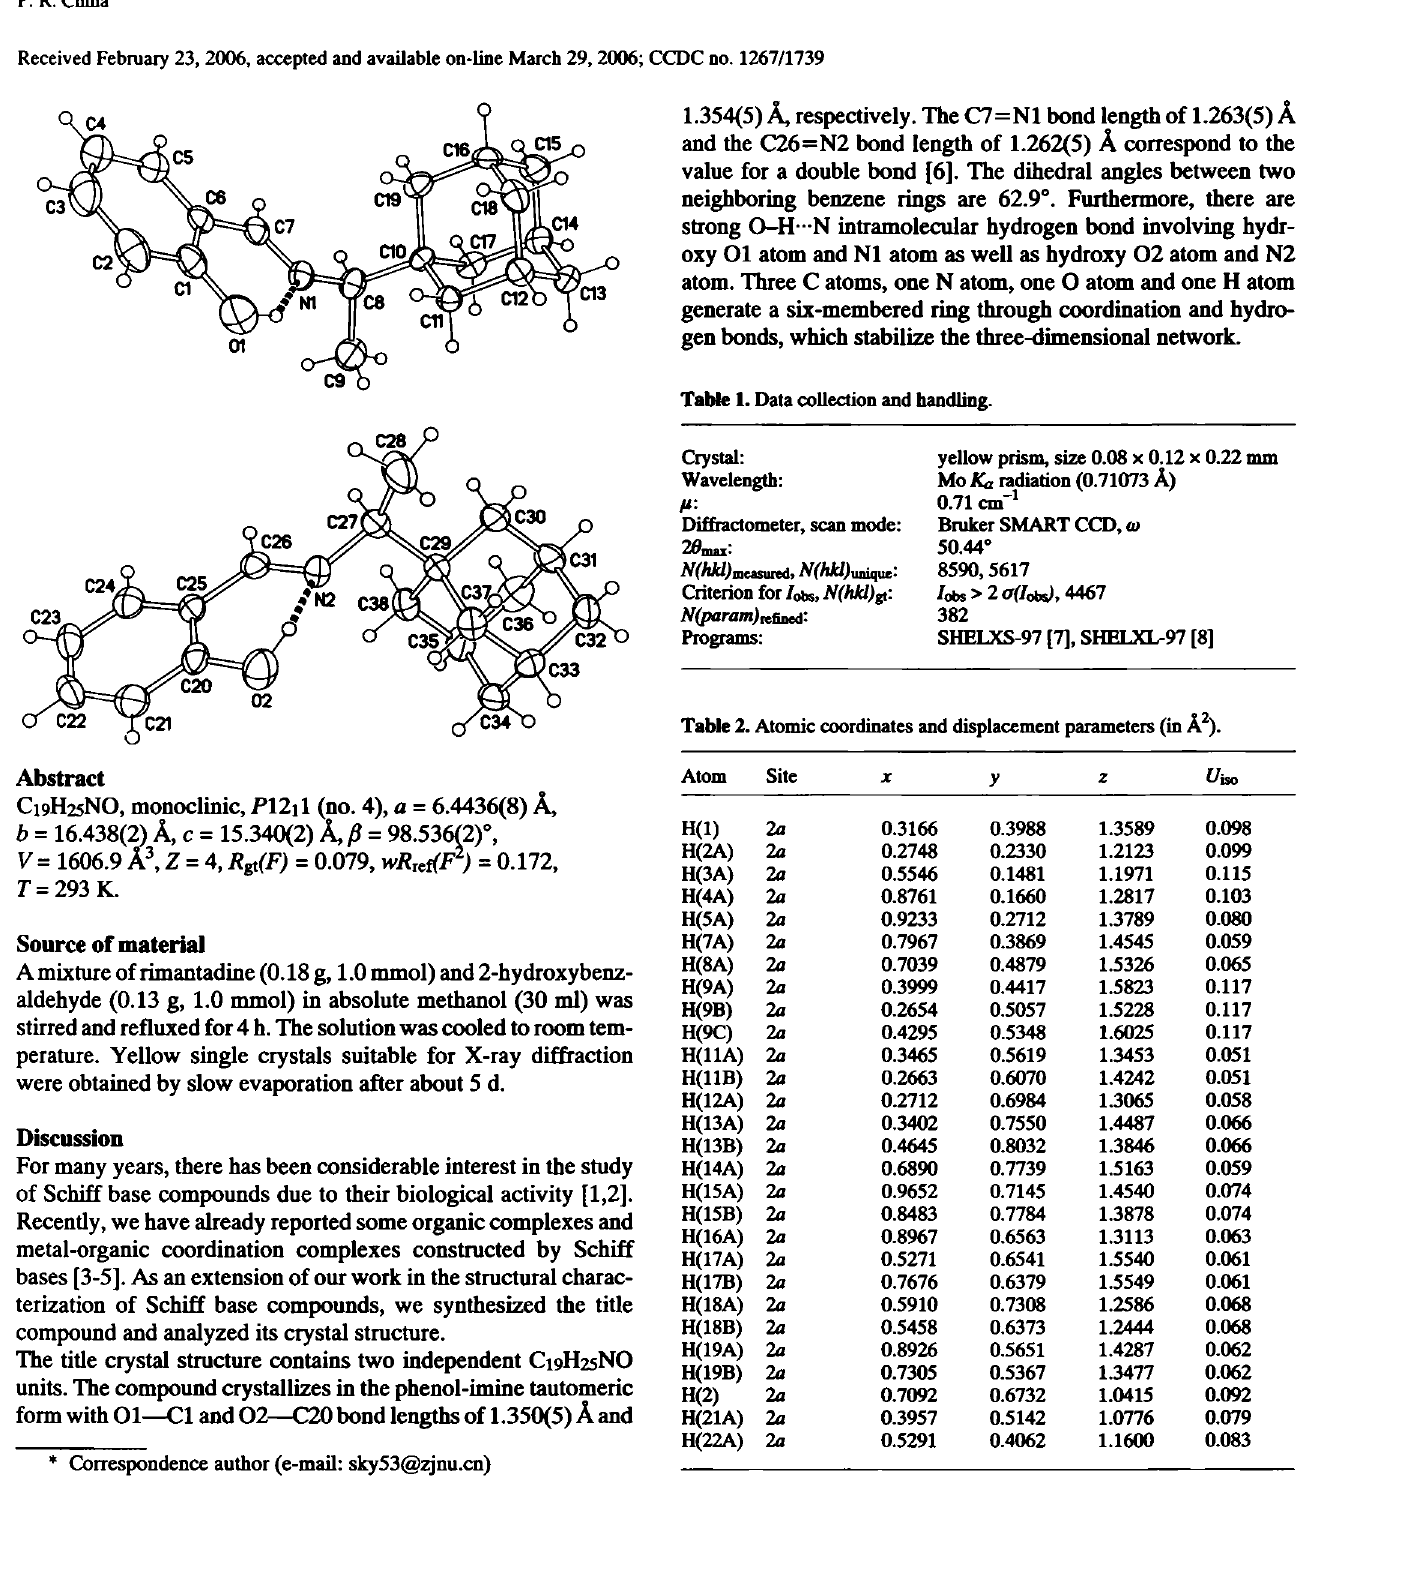
Table I. Data collection and handling.